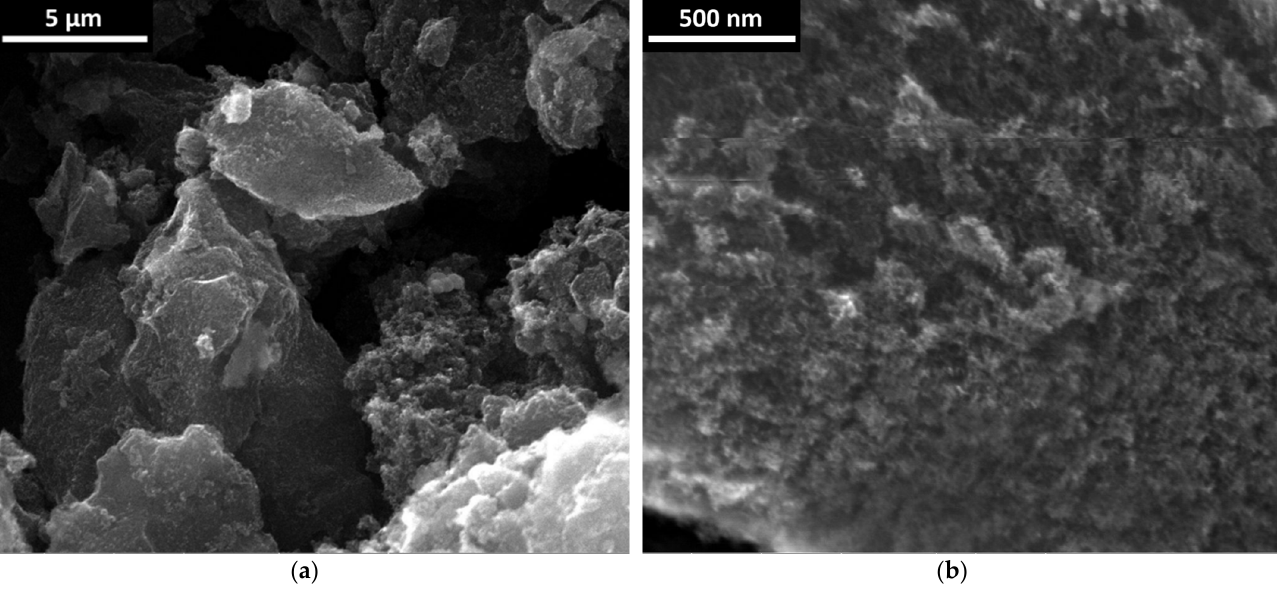
( b ) Figure 2. Distribution of diameter of the NDS particles in a suspension of NDS powder in acetone, obtained with ( a ) DLS and ( b ) LD methods. The size distribution for NDS aggregates/agglomerates consisted of peaks at ~250 nm and ~950 nm, obtained using DLS (Figure 2a), and at ~3.2 μ m, obtained using LDA (Figure 2b). The difference in the size distributions determined by the DLS and LDA can be at- tributed to the additional pretreatment using ultrasound with higher power when the size distributions were measured by the DLS method, compared to the treatment of the NDS in the circulation system when the size distributions was measured by LD. NDS size distributions were also obtained for additional liquid media, such as DMSO, ethanol, and isopropanol, as well as for different time periods after ultrasoni- cation: 0 h, 24 h, 120 h, 1 week, 3 weeks, and 4 weeks. The results were very close to the ones obtained for NDS dispersion in acetone soon after ultrasonication (in the range of an error). The results of the DLS measurements for different liquid media and time periods after ultrasonication are presented in Supplementary Materials. 10